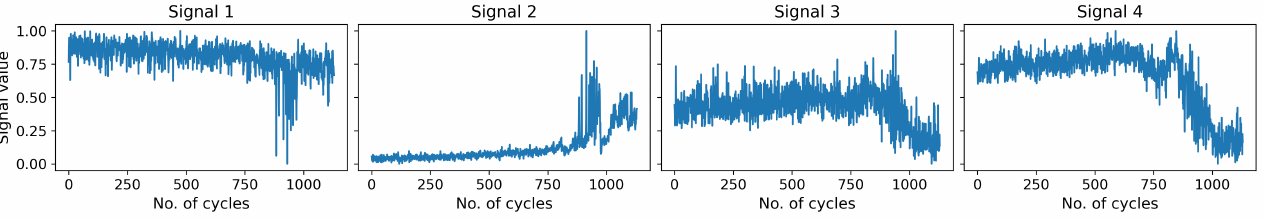
Figure 6. { X 1 , X 2 , X 3 , X 4 } collected on our